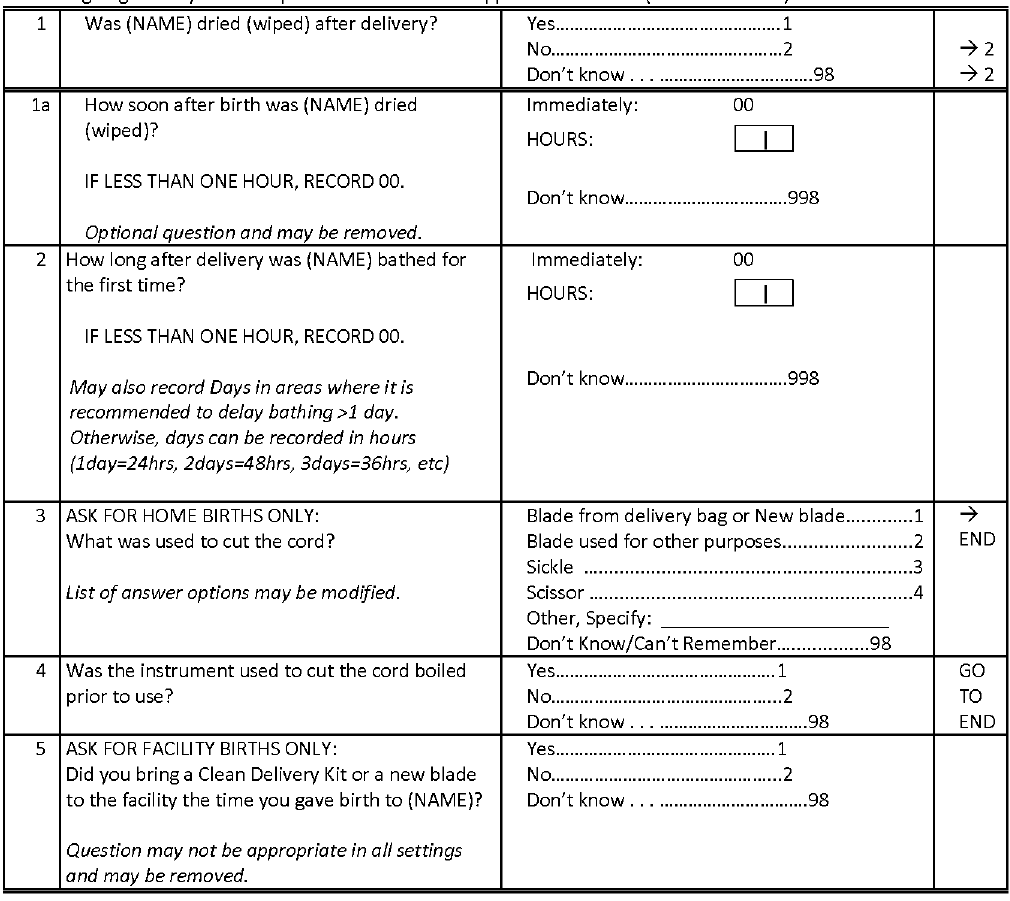
Figure 3. Standard questionnaire for measuring coverage of immediate newborn care.